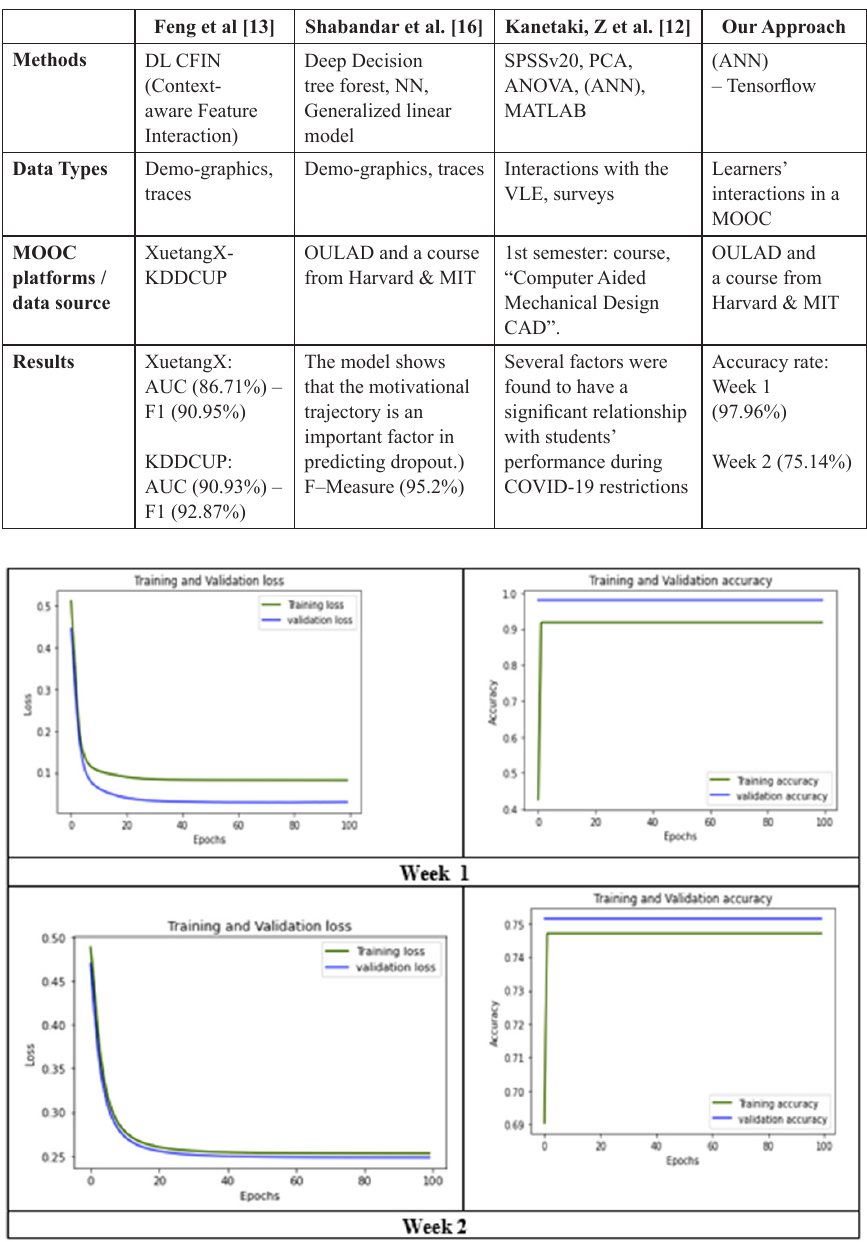
Fig. 5. Training and validation results (loss and